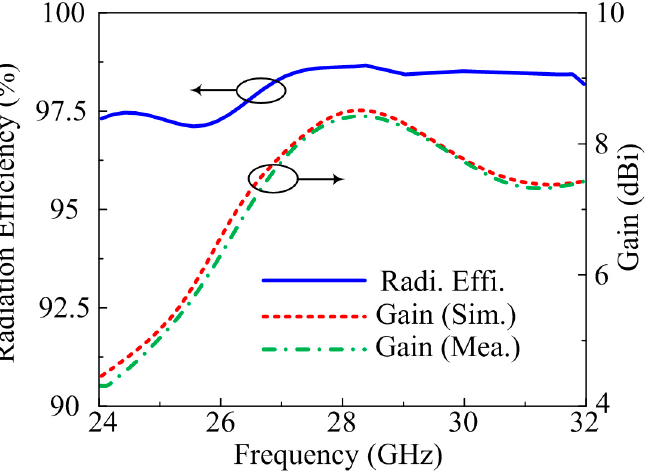
Figure 11. Comparison among gain and numerically calculated radiation efficiency of MIMO an- tenna with parallel and inverted structure element.